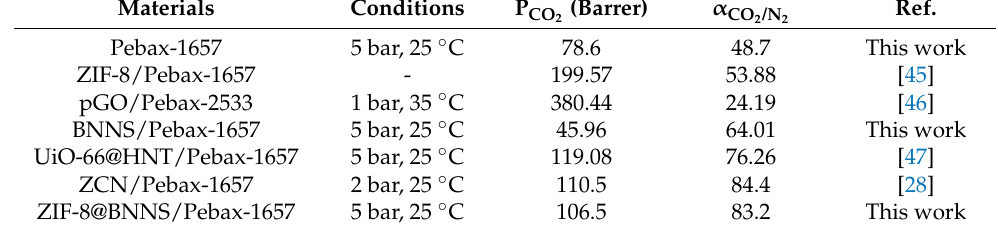
Table 4. Comparison of CO 2 separation performance of MMMs in this work and the literature.